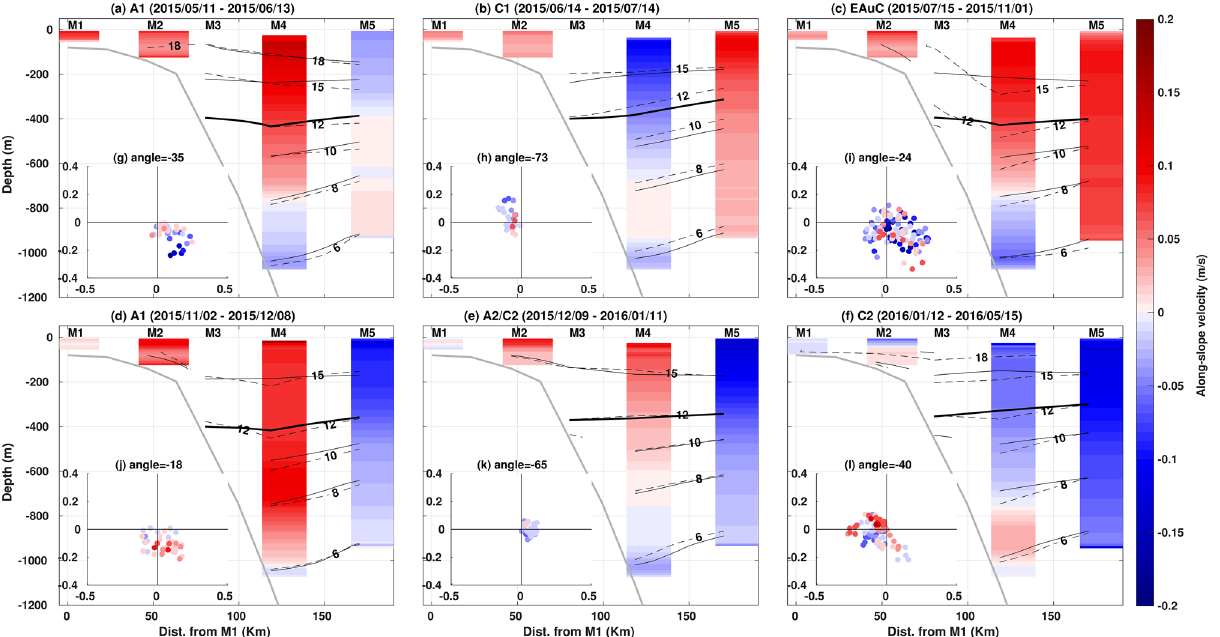
Figure 4. Mean U velocity (red-blue shade) and temperature (solid black line) fields, and daily average temperature (dashed lines) for the mesoscale structures: ( a ) A1, ( b ) C1, ( c ) EAuC, ( d ) return of A1, ( e ) dipole A2/C2, and ( f ) (C2). The daily average temperature fields are from the same days as in Fig. 2: ( a ) 2015/5/11, ( b ) 2015/7/7, ( c ) 2015/8/26, ( d ) 2015/11/2, ( e ) 2016/1/6 ( e ), and 2016/4/18 ( f ). The 12 ◦ C is highlighted as a solid bold black line. The hodographs of the upper 270 m depth-averaged water flow (dots) combined with along- slope flow depth-averaged between 840 m and 1120 m depth (red-blue shade equal to the colorbar) for each mesoscale event mentioned in ( g ), ( h ), ( i ), ( j ), ( k ), and ( l